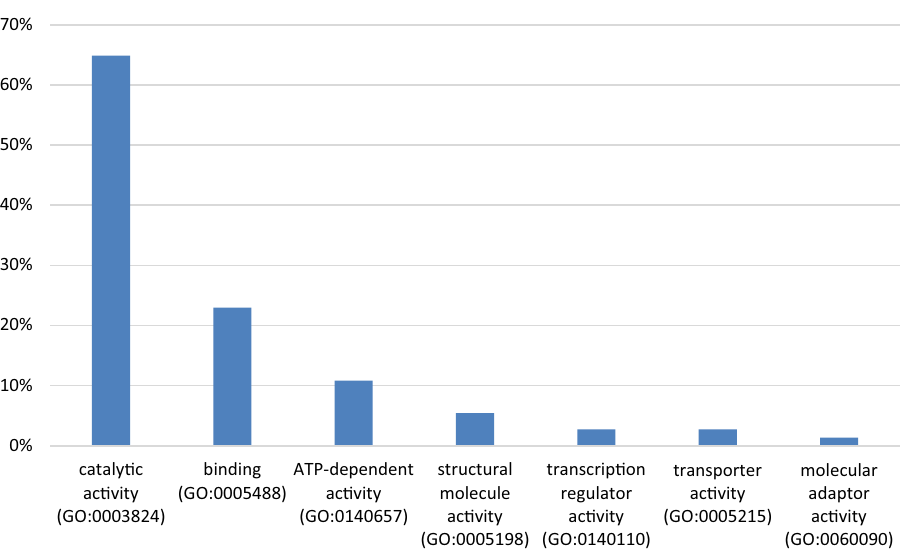
Figure 3. Functional classification of the 74 genes of interest. Using the PANTHER Classification System (17.0) 58 showed that 65% of the 74 aforementioned genes have a catalytic function, which relates to